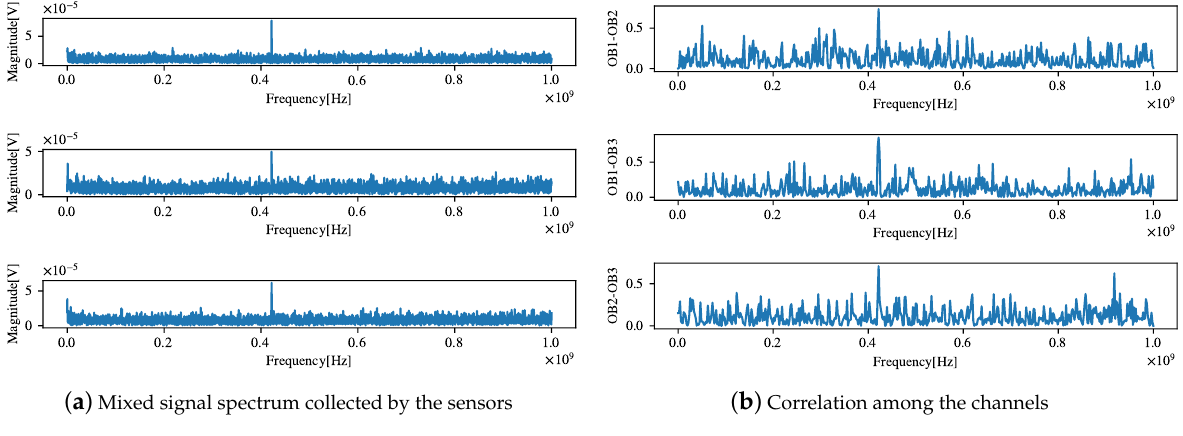
Figure 20. Mixed signal spectrum collected by the sensor and correlation analysis. Table 10. Performance indices for each algorithm at the end of the